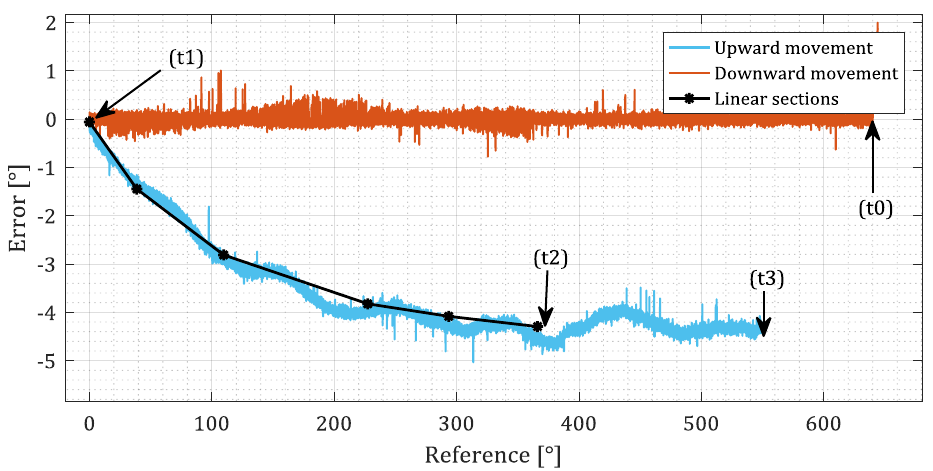
Figure 7. Data collected for the calibration-the error of the encoder during downward movement, a turn and then the upward movement. The typical points are identified. The section between (t1) and (t2) is split into five linear regions.